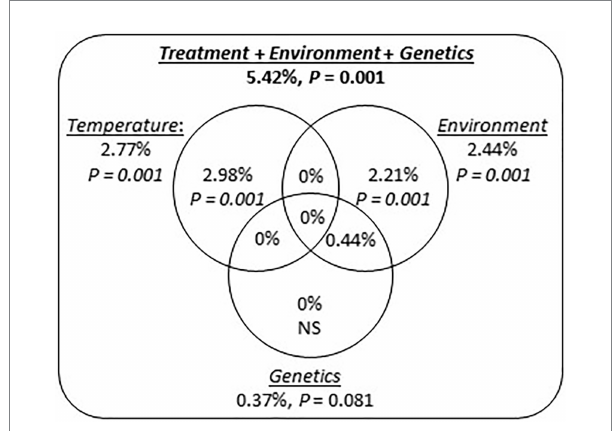
FIGURE 6 Factors influencing transcript expression in P. borealis . Venn diagram representing the proportion ( adj. R 2 ) of gene expression level explained by exposure temperature ( Temperature ), environmental conditions at origin ( Environment ) and population genetic differentiation ( Genetics , i.e., pairwise F ST between origins). Number outside circles refer to total percentage of variation explained by each underlined factor. Numbers inside circles indicate the marginal contribution to transcript expression by each factor. Percentages within intersections indicate shared contribution across different variables. Significance of total and marginal contribution to gene expression was tested by permutations test, using 999 randomizations.